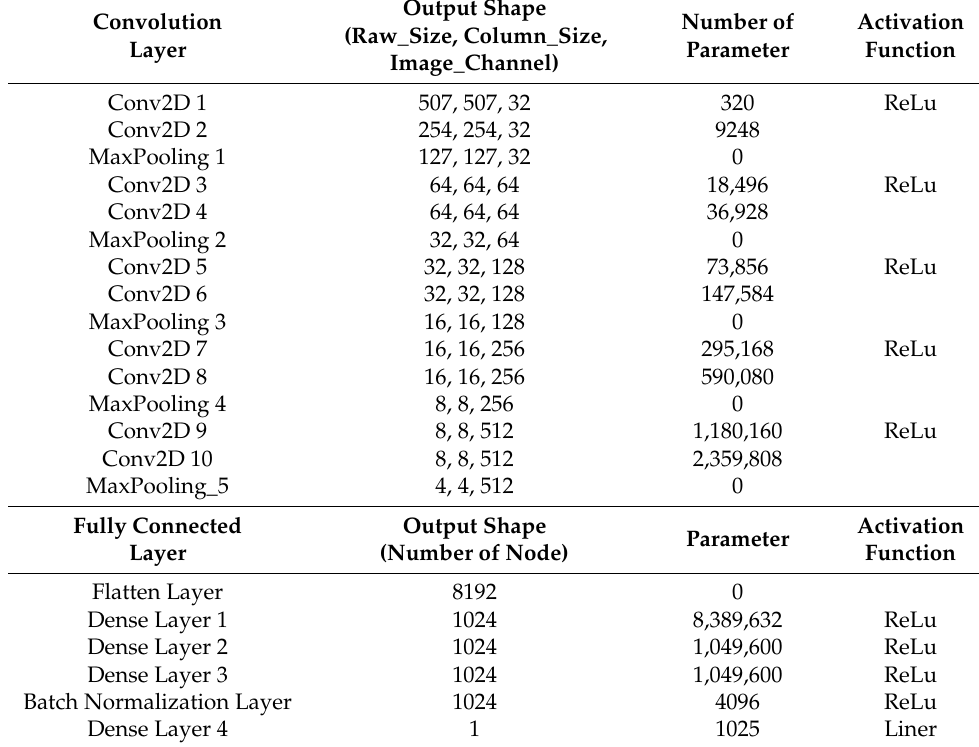
Table 4. Summary of CNN model structure used in this